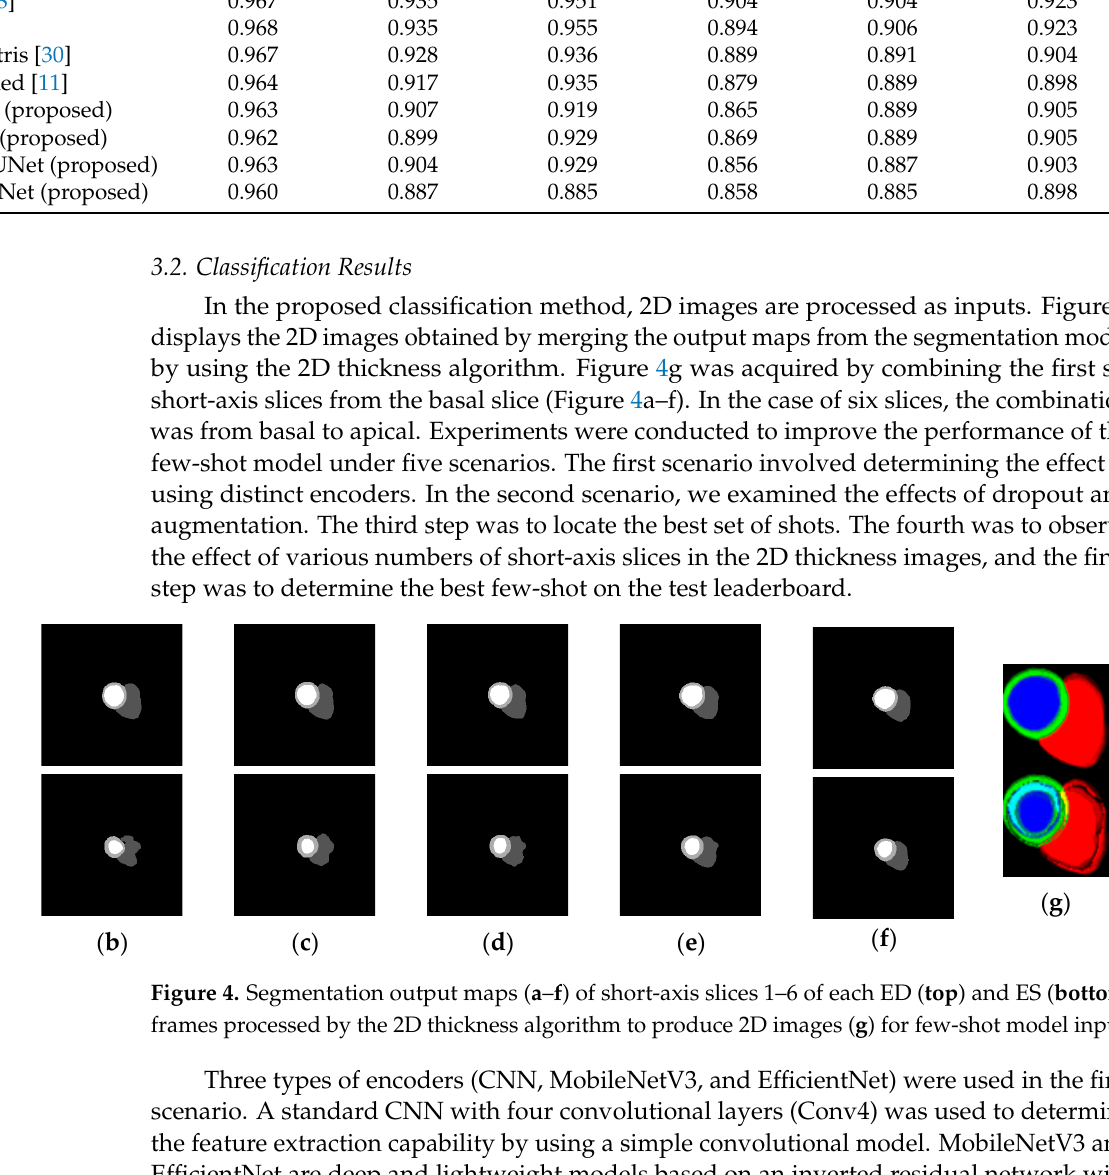
Table 3. Accuracy results of application of various encoder few-shot models to the validation set.